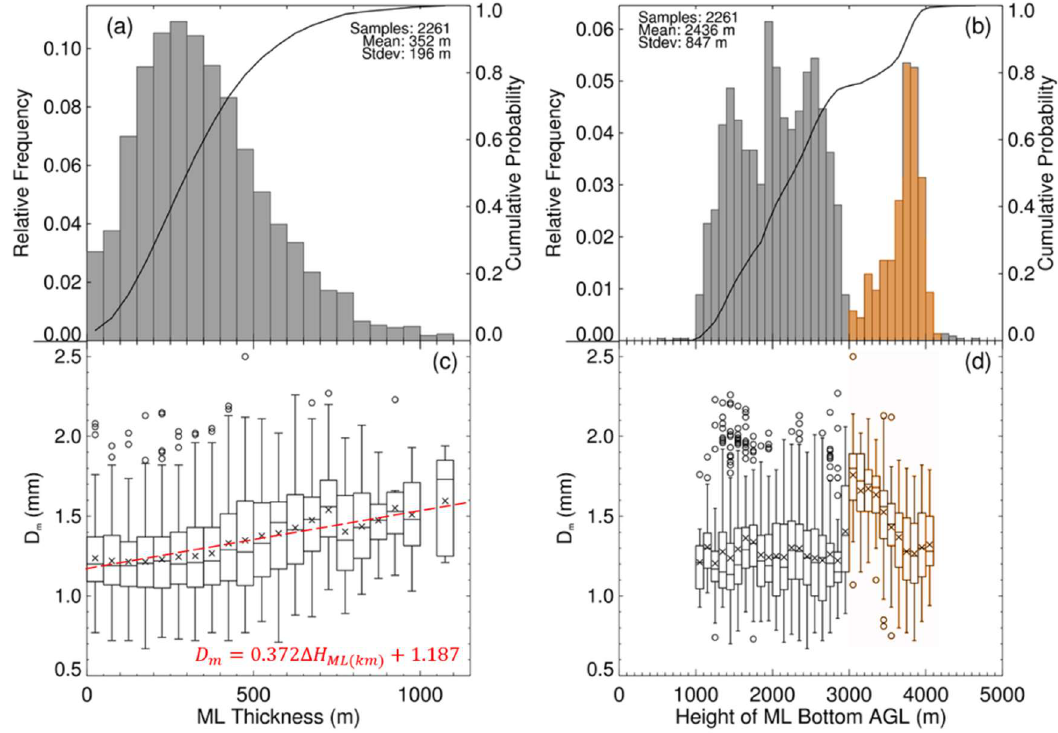
Figure 2. Polarimetric radar-based melting layer (ML) characteristics and two-dimensional video disdrometers (2DVD) measured D m from the Huntsville, Alabama and IFloodS stratiform rainfall cases. Relative frequency distribution of ( a ) ML thickness and ( b ) ML bottom, respectively, and the solid curve represents the cumulative frequency distribution; ( c , d ) are box and whiskers plots of D m corresponding to the ML thickness and ML bottom, respectively, where each box is bounded by the 25th and 75th quartiles and the mean value in each D m bin is represented by an “X.” The whiskers indicate extremes and extend to 1.5 times the interquartile range. Outliers (i.e., values exceeding 1.5 times the interquartile range) are represented by circles. The dashed line in ( c ) represents the best fit line from linear least squares regression where D m is the dependent variable and the ML thickness (ΔH in km) is the independent variable.